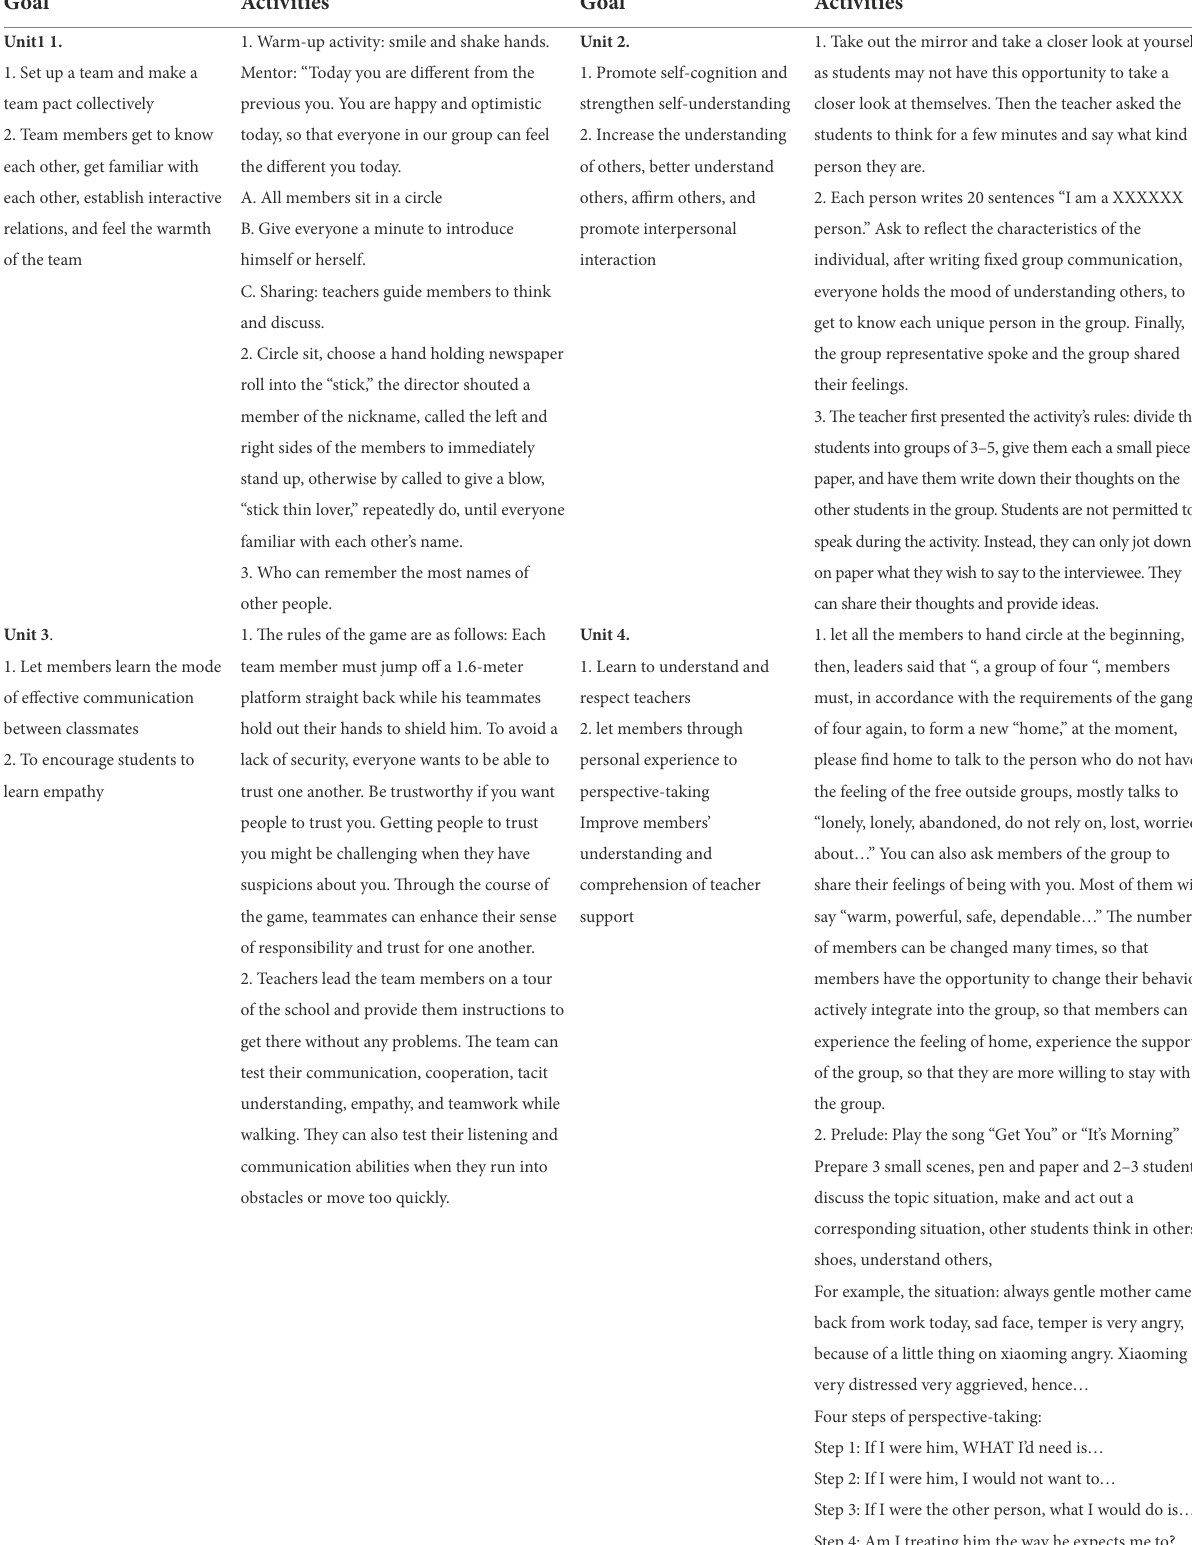
TABLE 1 Intervention activities. Goal Activities